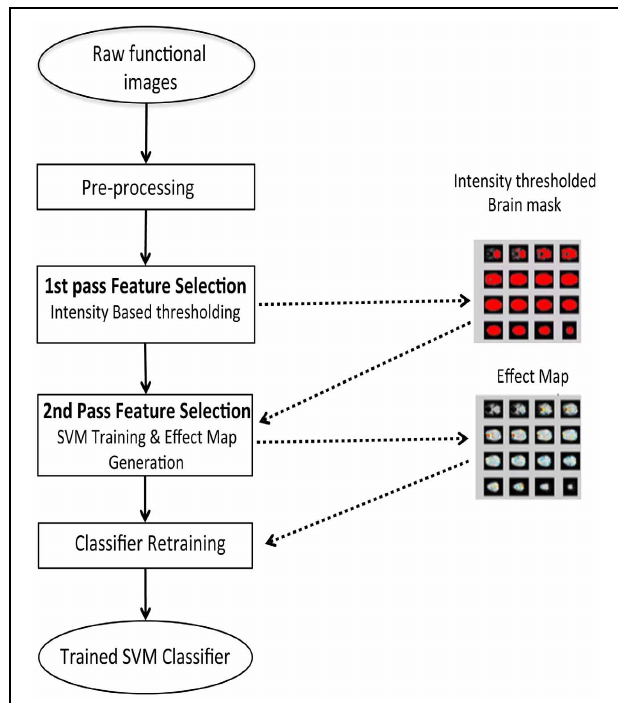
FIGURE 4 | Two step feature selection mechanism for the online subject-dependent analysis. Step 1: Intensity based thresholding which removes voxels which do not belong to brain, and Step 2: SVM training and effect map generation which selects the voxels involved in the tasks performed by the